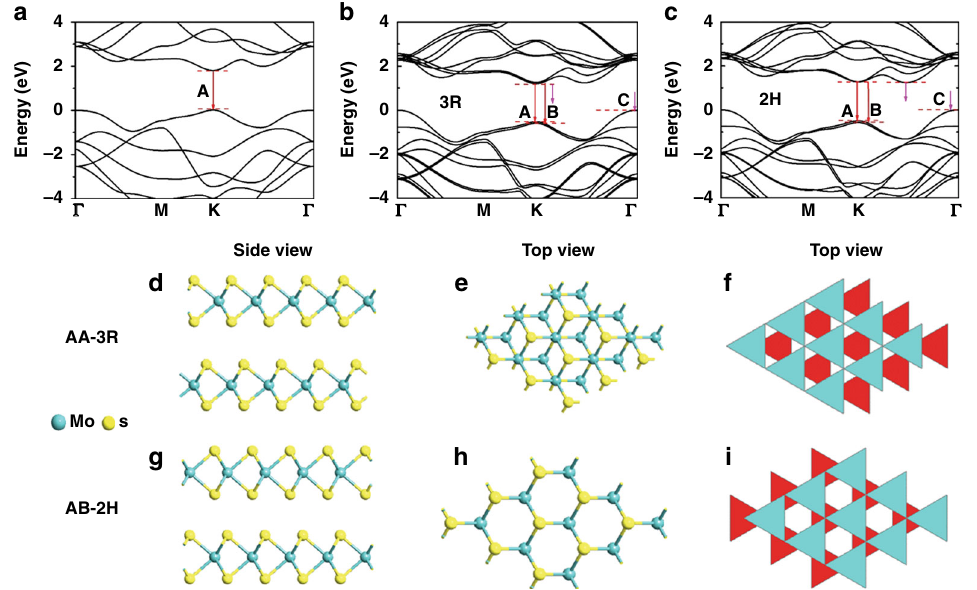
Fig. 4 Atomic structure and band structure of the bilayer MoS 2 crystals. The calculated energy band structures of a MoS 2 monolayer, b AA-stacking MoS 2 bilayer and c AB stacking MoS 2 bilayer. d The side view and e top view in ball-and-stick model as well as f top view in MITSUBISHI column model of the atomic structures for AA stacking MoS 2 bilayer; the counterpart views g , h , and i for AB stacking MoS 2 bilayer. In d , e , g , and h , the blue solid spheres represent Mo atoms and the yellow ones S atoms. In f and i , the red and blue triangles stand for the bottom and upper MoS 2 layer, respectively, where Mo atoms locate at the center of each triangle and S atoms at the apex of each